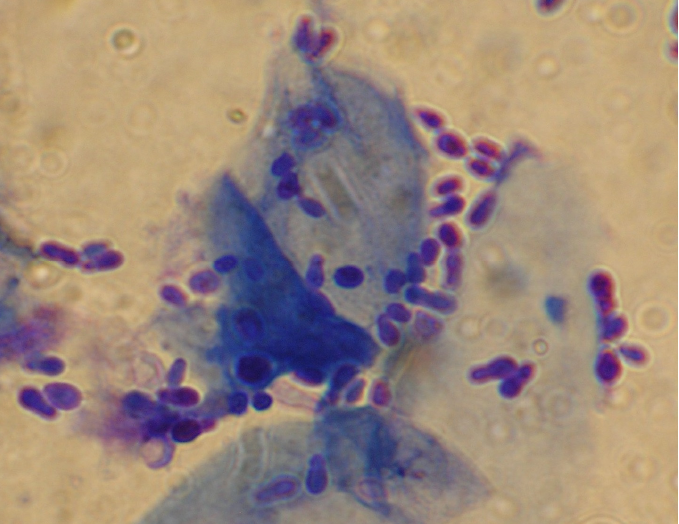
Figure 3. Skin cytology from a dog with Malassezia dermatitis. Numerous typical peanut-shape budding yeasts (1000-fold magnification, Hemacolor ® rapid staining kit) . Table 1. Antifungal agents used to treat Malassezia dermatitis and otitis in the dog.